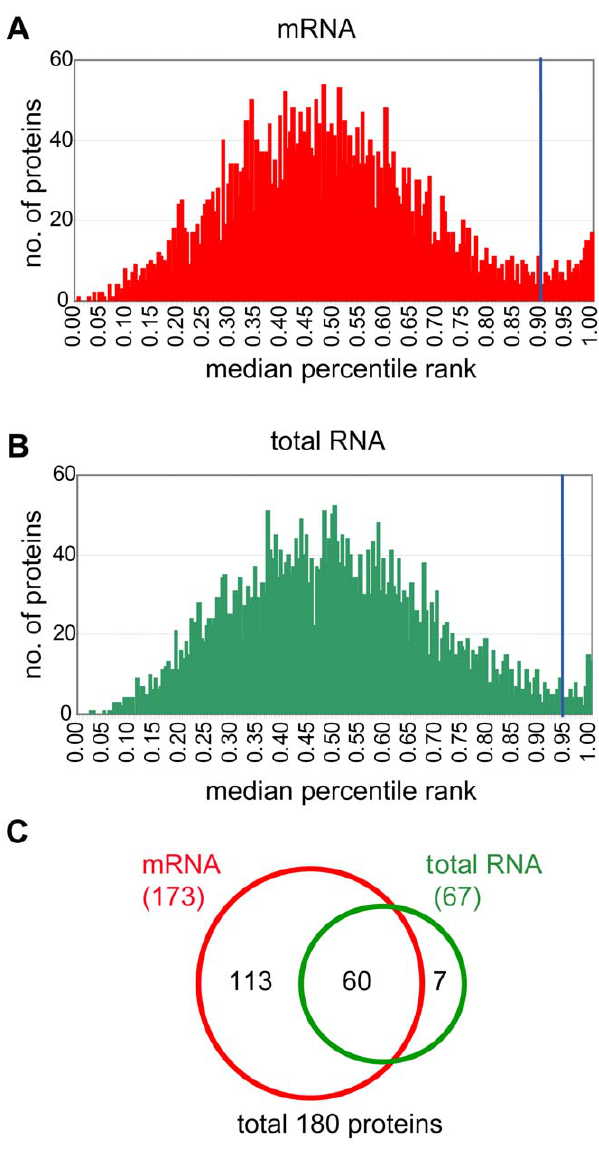
Figure 2. Selection of mRNA and total RNA-binding proteins. (A) Distribution of ranked median signal intensities resulting from protein microarrays probed with mRNAs. The trough at 0.9 was taken as cut-off and all proteins with greater ranks were selected as mRNA binders. (B) Distribution of ranked median signal intensities resulting from arrays probed with total RNA. The trough at 0.95 was taken as cut- off and all proteins with greater ranks were considered as total RNA binders. (C) Venn Diagram representing overlap between proteins binding to total RNA and mRNAs.